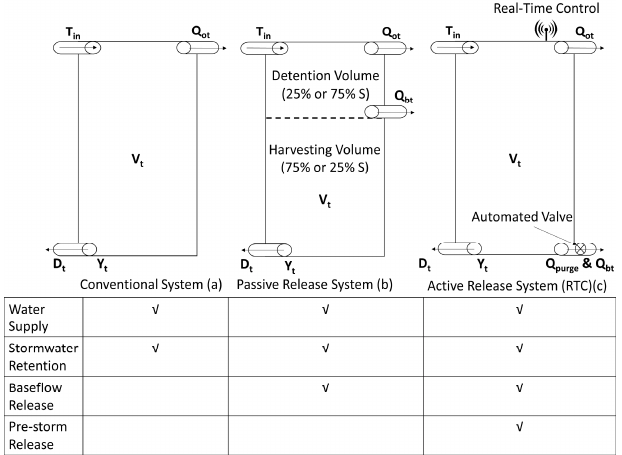
Figure 1. Schematic representation and functions of the three types of RWH: ( a ) Conventional System; ( b ) Passive Release System; and ( c ) Active Release System using Real-Time Control. Tin is tank inflow (L/6 min), Q ot is tank overflow (uncontrolled discharge) at timestep t (L/6 min), Y t is rainwater yield at timestep t (L/6 min), V t is volume in store (L) during time interval t, D t is demand at timestep t (L/6 min), S is tank size (L), Q bt is controlled baseflow discharge at timestep t (L/6 min) and Q purge is controlled pre-storm release subject to rainfall forecast (L/6 min).